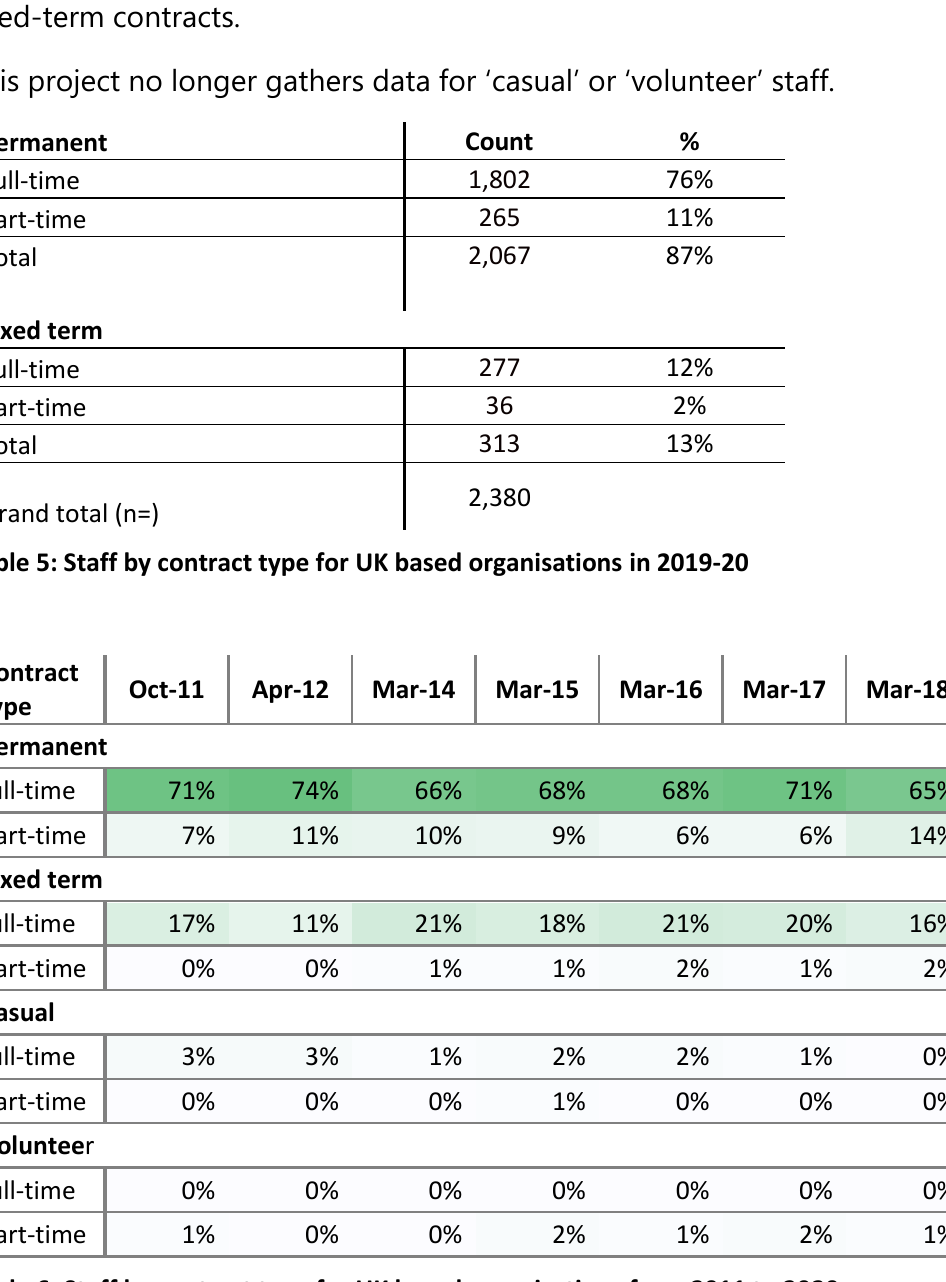
Table 6: Staff by contract type for UK based organisations from 2011 to